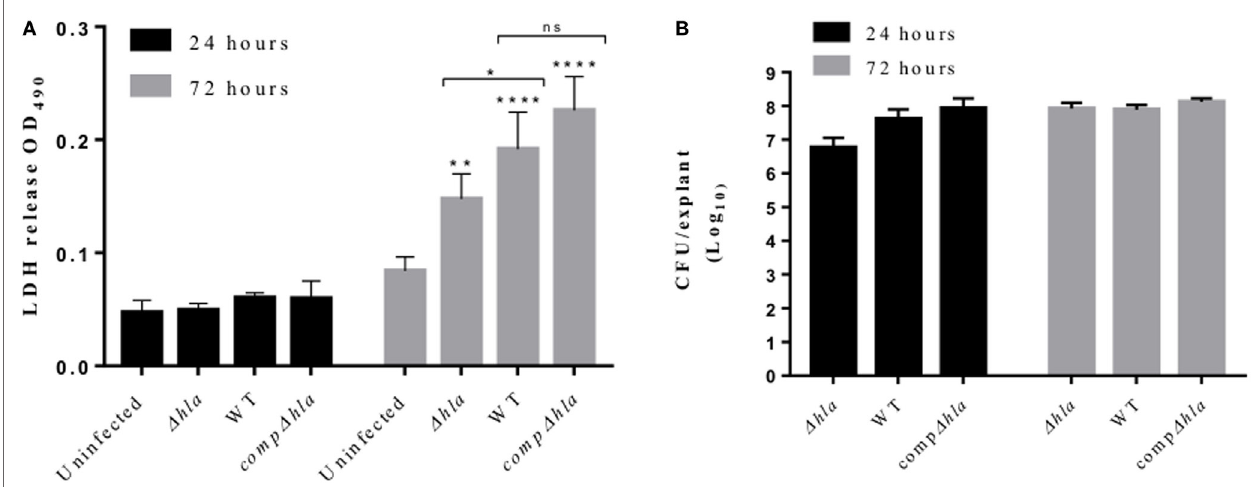
FigUre 5 | Hla mediates tissue toxicity during Staphylococcus aureus skin infection. Human skin explants were infected with S. aureus USA300 LAC wild type, its isogenic hla mutant, and the complemented strain (comp Δ hla ). (a) Lactate dehydrogenase (LDH) released from the skin during infection with S. aureus wild-type and hla mutant LAC USA300 strains. Each bar represents the mean ± SD ( N = 3). (B) Colony-forming unit (CFU) of S. aureus recovered 24 and 72 h post-infection. Each bar represents the mean ± SD ( N = 3). Statistically significant differences were determined by two-way ANOVA, with Tukey’s multiple comparison tests, * p < 0.05, ** p ≤ 0.001, and **** p < 0.0001. Asterisks on bars are comparisons between infected and uninfected groups while lines are the comparison between infected